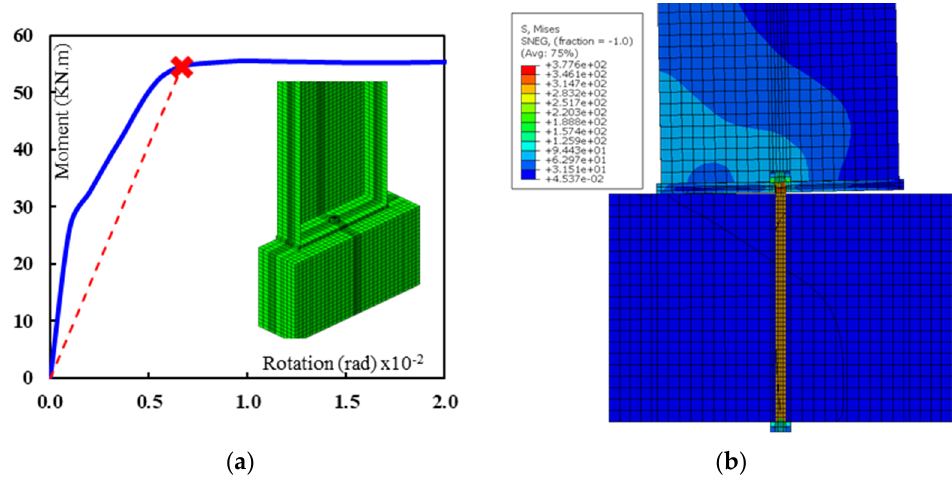
Figure 10. Specimen B2-D18-S000-T18: ( a ) moment–rotation curve, ( b ) deformed shape–von misses stress at H/150 column drift.